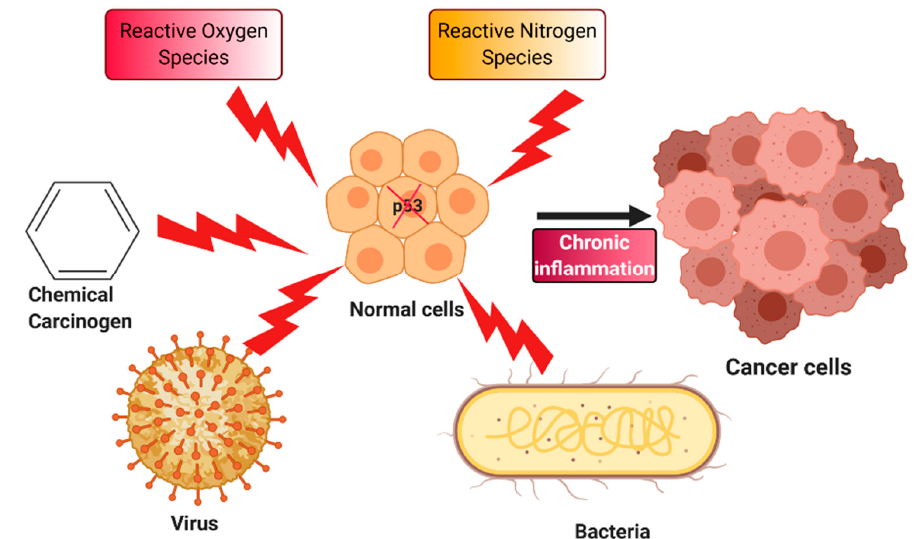
Figure 2. Chronic inflammation-induced carcinogenesis: The process of carcinogenesis sometimes involves chronic inflammation induced by chemical carcinogens, reactive oxygen and nitrogen species, viruses, and bacteria. All these agents trigger mutation in the p53 gene that ultimately leads to the transformation of normal cells into cancer cells.